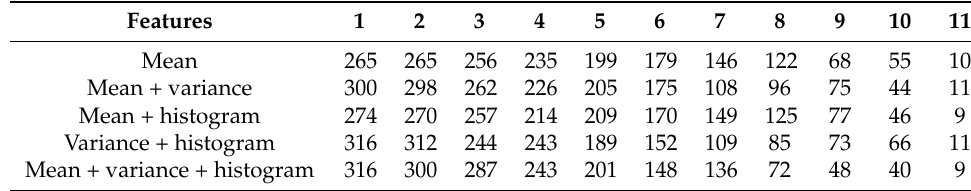
Table 5. K = 11 number of images in each cluster.